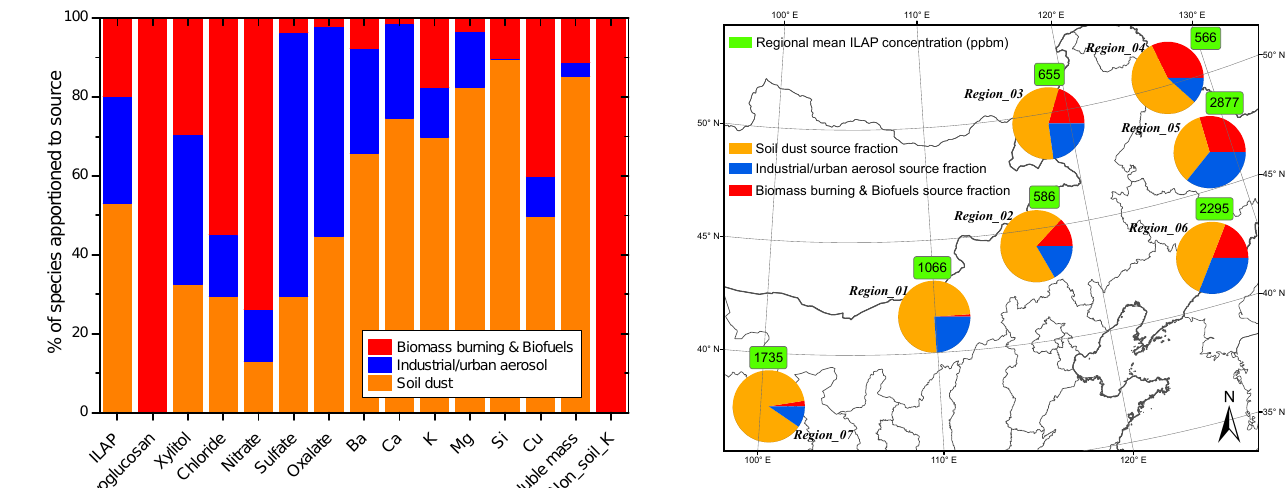
Fig. 4. Average source apportionment for each of the seven regions of northern China discussed in the text. Note that the apportionment is of the light absorption by insoluble impurities in the